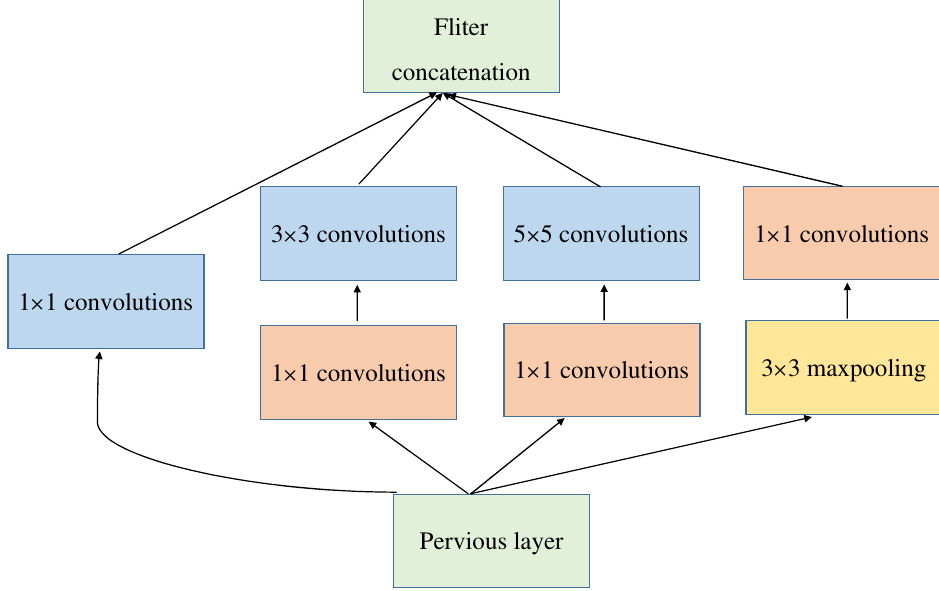
Figure 8. Diseases Inception Model structure